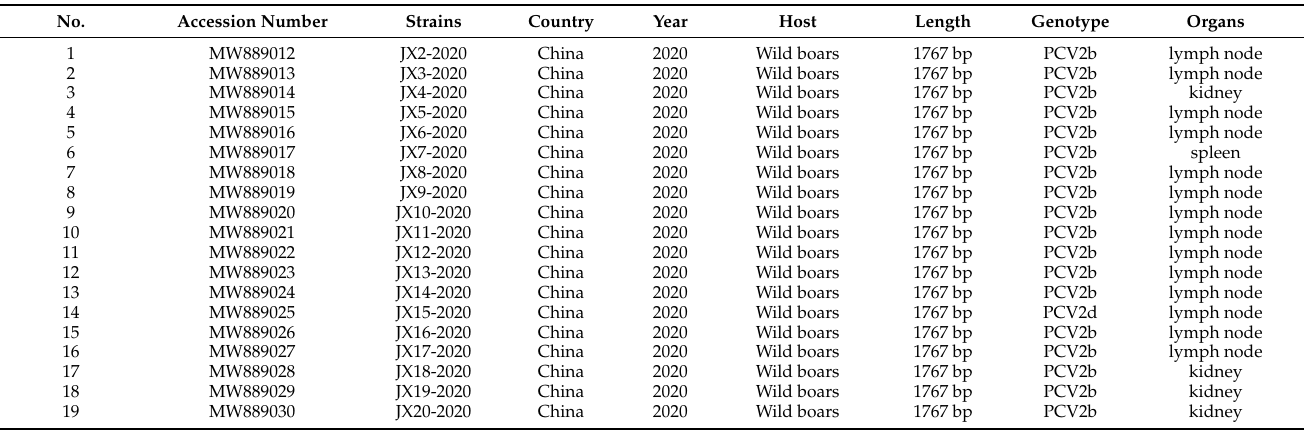
Table 3. The information of PCV2 strains obtained in this